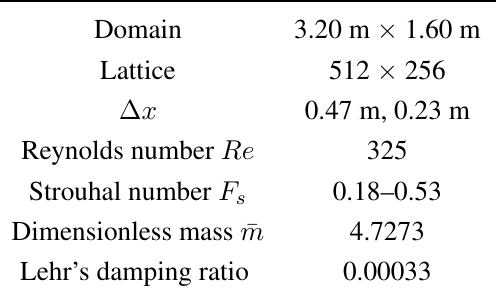
Table 5. Vortex-induced vibrations test case parameters.